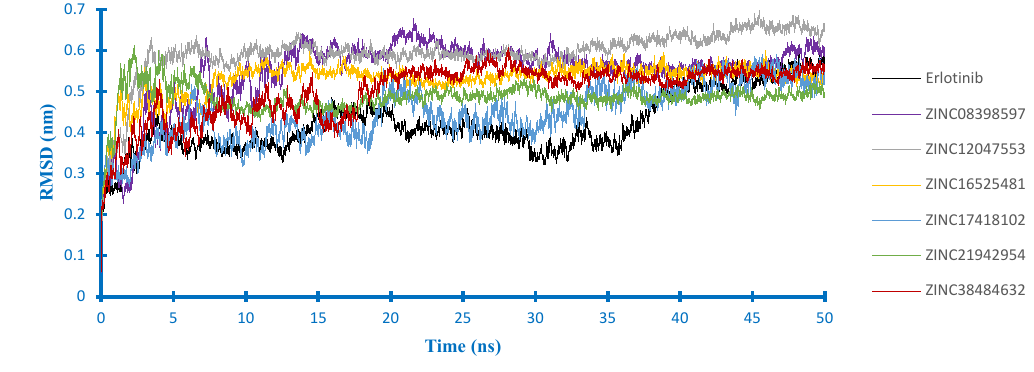
Figure 5. Backbone RMSD of the EGFR complexes.